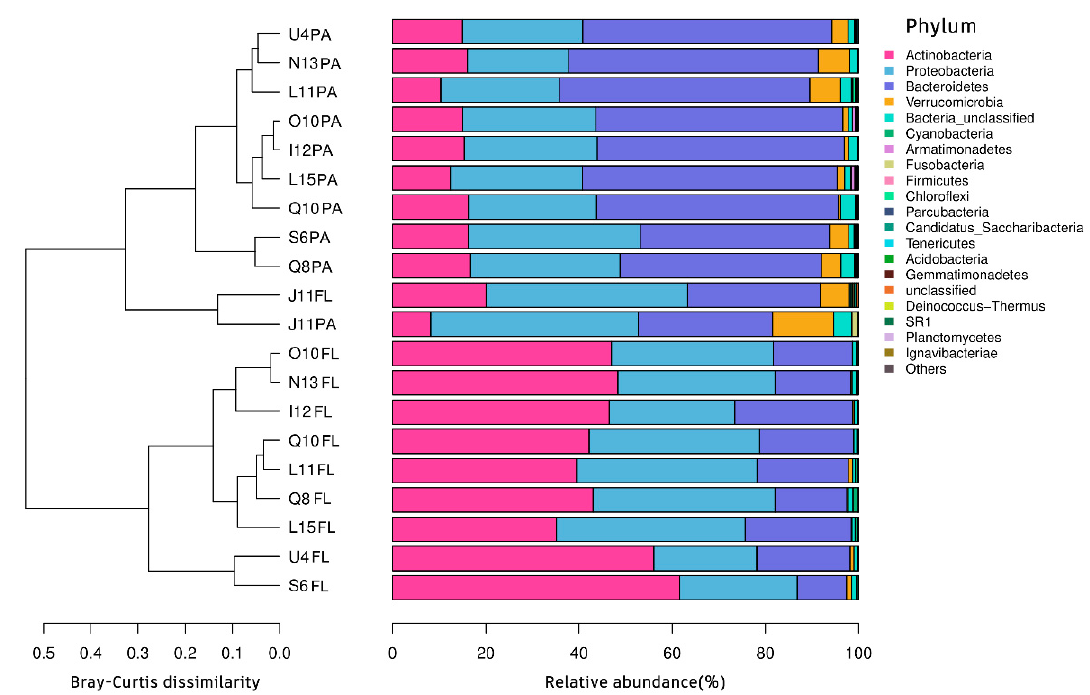
Figure 4. Bacterial community composition of different sampling points based on the relative abundance at phylum level. PA: particle-attached bacteria. FL: free-living bacteria.